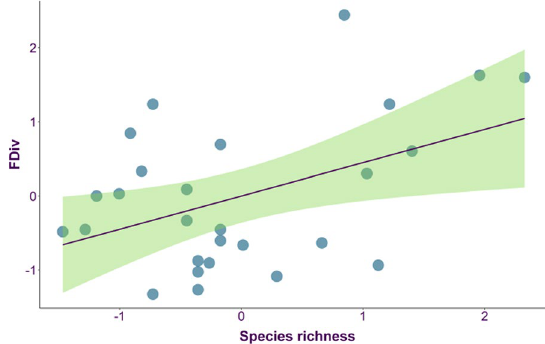
Fig. 5 Scatter plot of the relationship between functional divergence (FDiv) and species richness (multiple R 2 community in the 27 sites studied along the Ganga River,